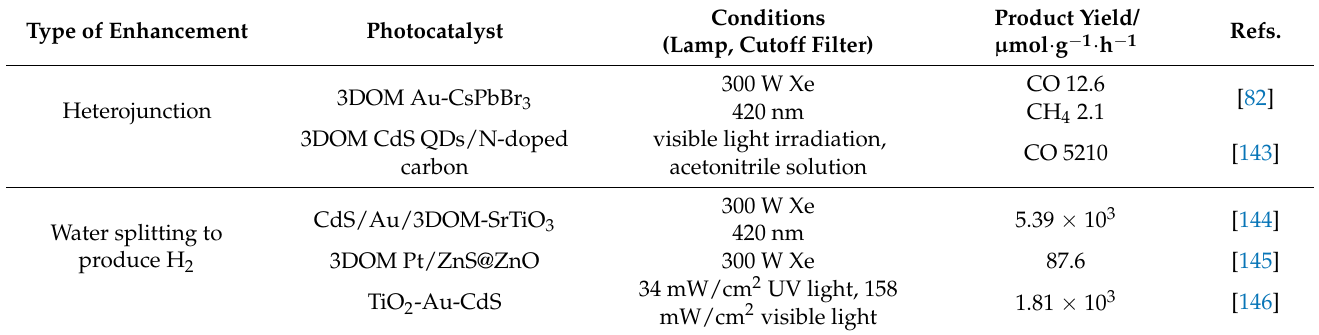
Figure 20. Proposed mechanism for the photocatalytic CO 2 reduction on 3DOM CdS QD/NC. Schematic illustration of the photocatalytic CO 2 reduction coupled with selective arylamine oxidation reaction system [143]. Table 6. Summary of the recent results on the photoreduction of CO 2 and H 2 O by 3DOM